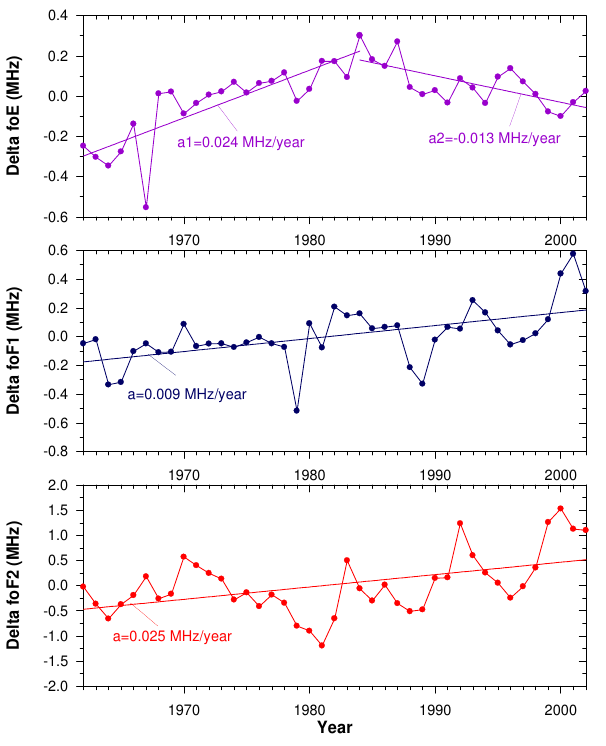
Fig. 2. Long-term trends of different ionospheric parameters ( fo F2, fo F1, fo E) observed at Phu Thuy after elimination of the solar influ- ences (Rz).